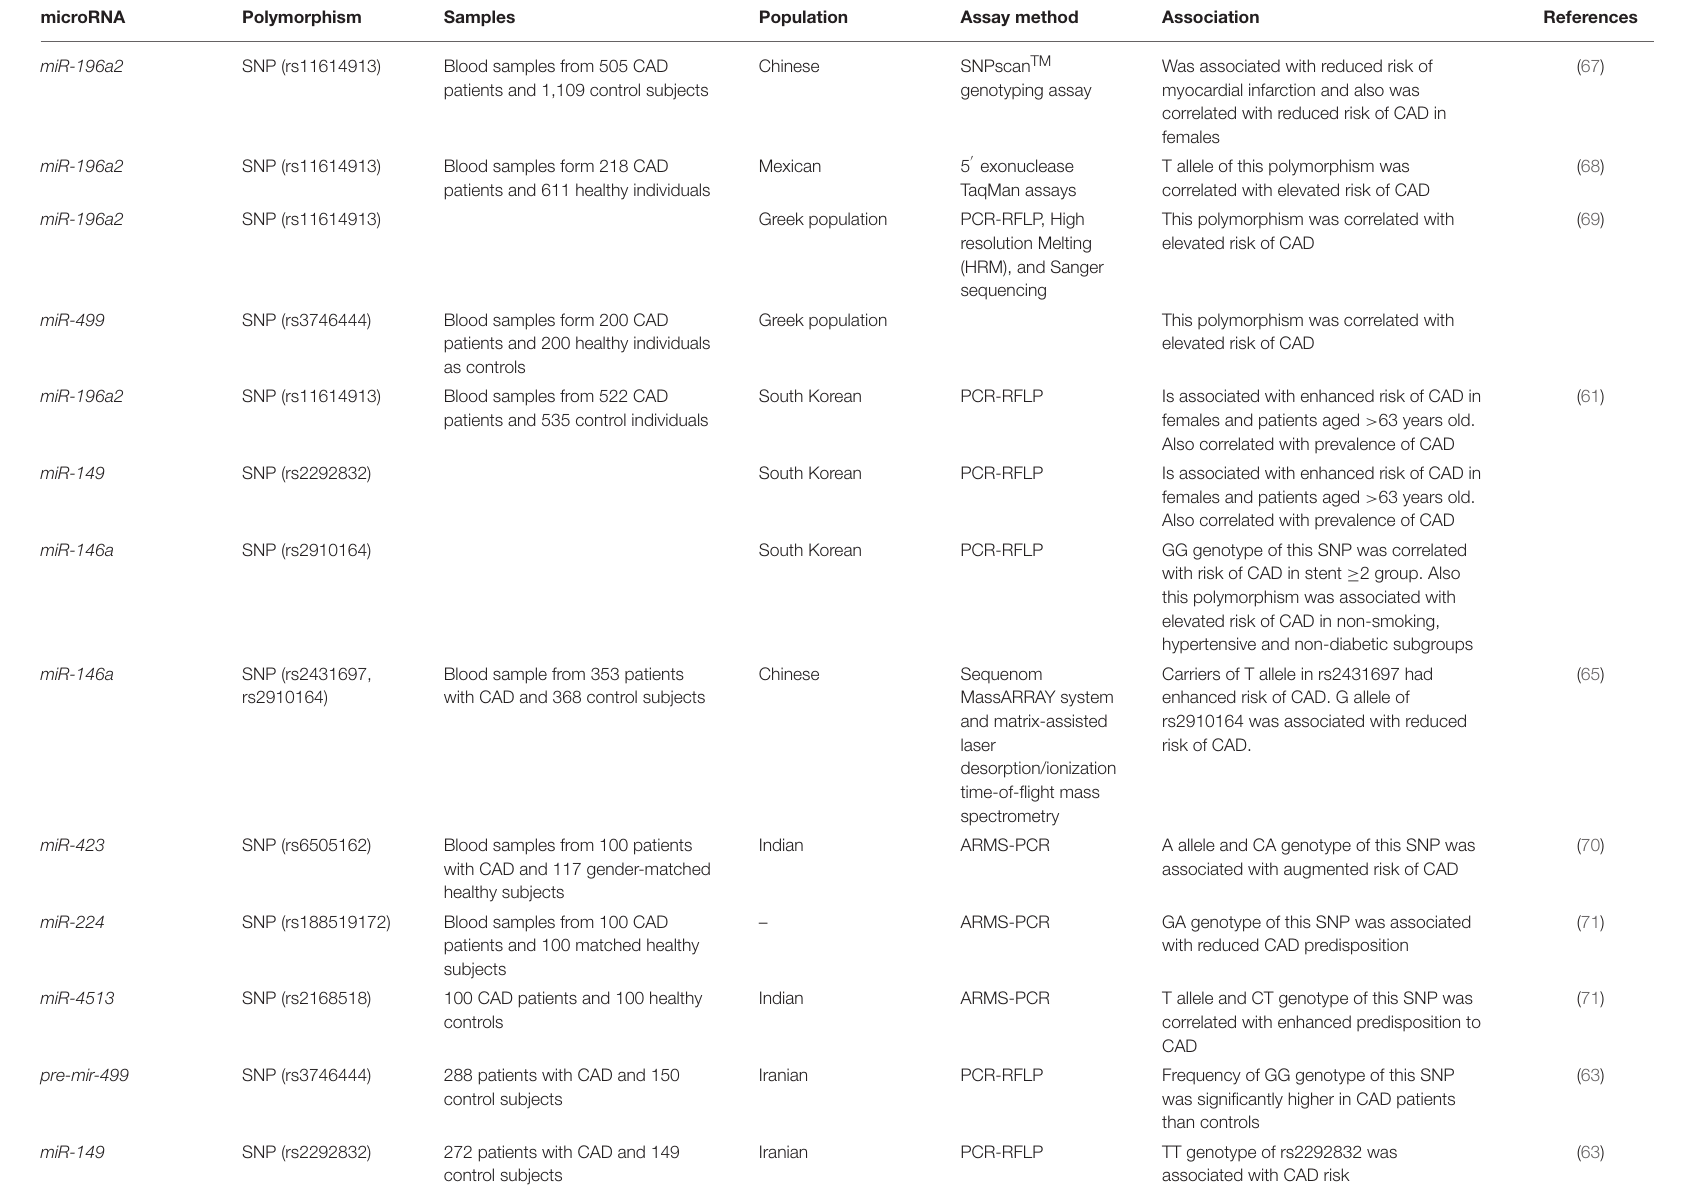
TABLE 5 | miRNA polymorphisms in